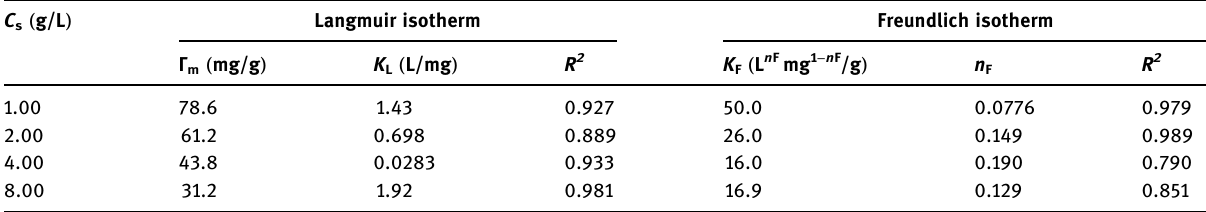
Table 3: Nonlinear fi t data of model parameters for Pb ( II ) sorption on 50% B/LDHs at di ff erent C s C ( g/L s